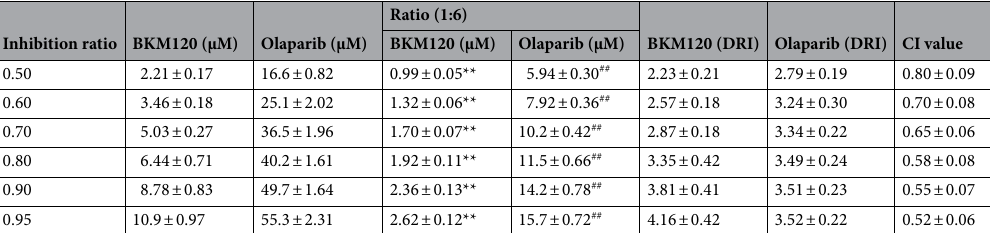
Table 1. DRI and CI values for the effects of combining BKM120 with olaparib on the proliferation of MDA-MB-231 cells. *P < 0.05 and **P < 0.01 compared to BKM120 alone treated group, # P < 0.05 and ## P < 0.01 compared to olaparib alone treated